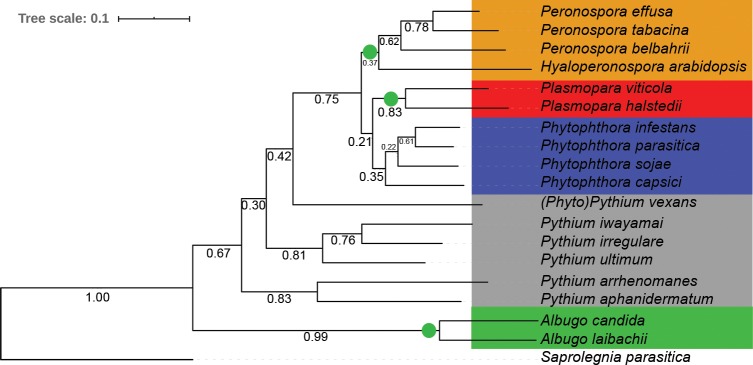
Maximum likelihood tree of 18 plant infecting oomycete species based on core othologous proteins.The tree was inferred from 152 single copy ortholog groups in which all species in the comparison where represented. Branch numbers represent bootstrap values of N = 12171 trees. Five taxonomic clusters were defined for further analysis; Hyaloperonospora/Peronospora (green), Plasmopara (red), Phytophthora (blue), Pythium (grey) and Albugo (green). The obligate biotrophic clades are highlighted using green circle.The fish infecting species Saprolegnia parasitica, was used as an outgroup.